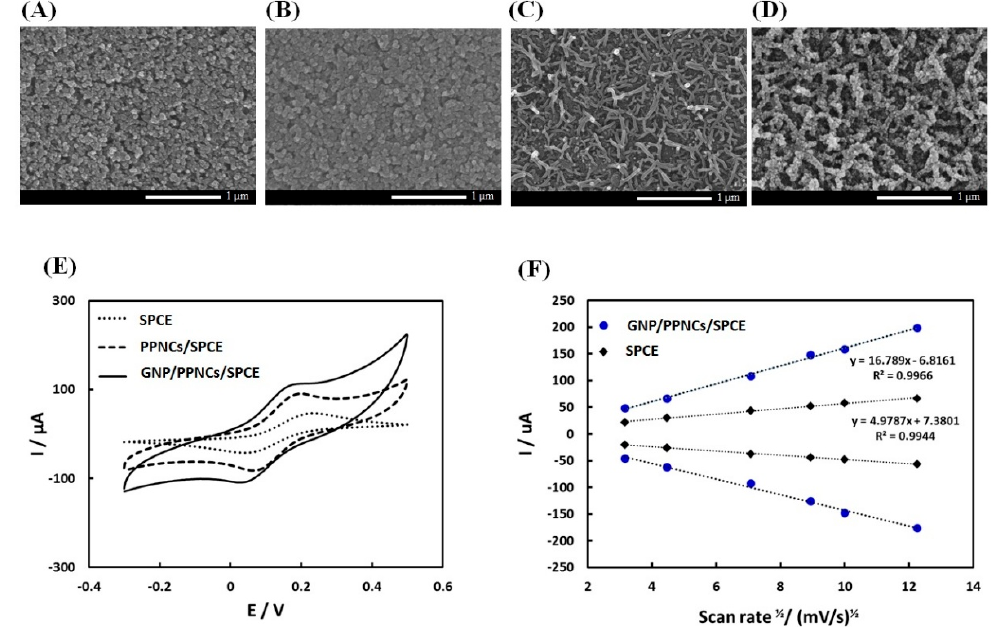
Figure 2. SEM images of ( A ) bare screen-printed carbon electrode (SPCE); ( B ) pre-nucleated SPCE; ( C ) NSA-doped PPNCs on SPCE (PPNCs/SPCE), and ( D ) GNP-decorated PPNC-NSA on SPCE (GNP/PPNCs/SPCE); ( E ) cyclic voltammograms of bare SPCE, PPNCs/SPCE, and GNP/PPNCs/SPCE in 0.1 M KCl containing 2 mM [Fe(CN) 6 ] 3 − /4 − in the range from − 0.3 to 0.5 V (vs. silver pseudo-reference electrode) at a scan rate of 50 mV·s − 1 , respectively; and ( F ) peak current versus square root of the scan rate for bare SPCE and GNP/PPNCs/SPCE, respectively.